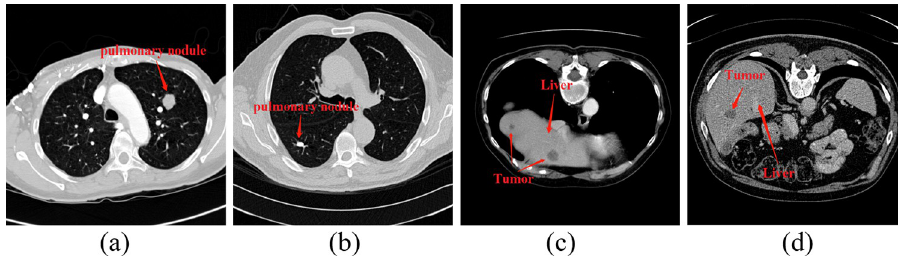
Fig 3. Distribution of tissue lesions in CT images. (a) and (b) are pulmonary nodules, and (c) and (d) are liver